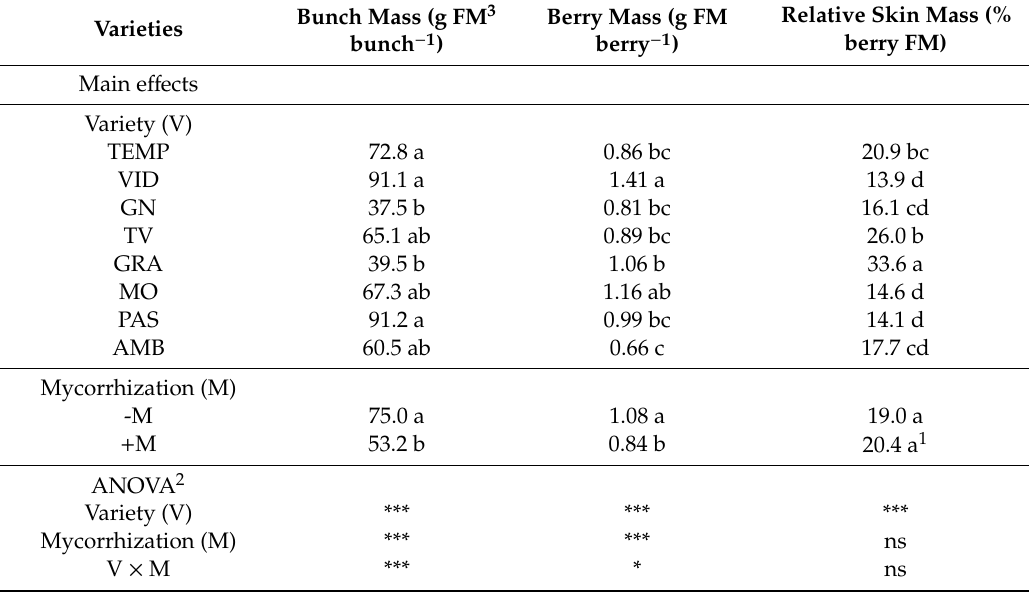
Table 3. Main e ff ects and their interaction bunch characteristics from fruit-bearing cuttings of ancient grapevine varieties inoculated with arbuscular mycorrhizal fungi ( + M) or non-inoculated (-M). The variety labels can be found in Table